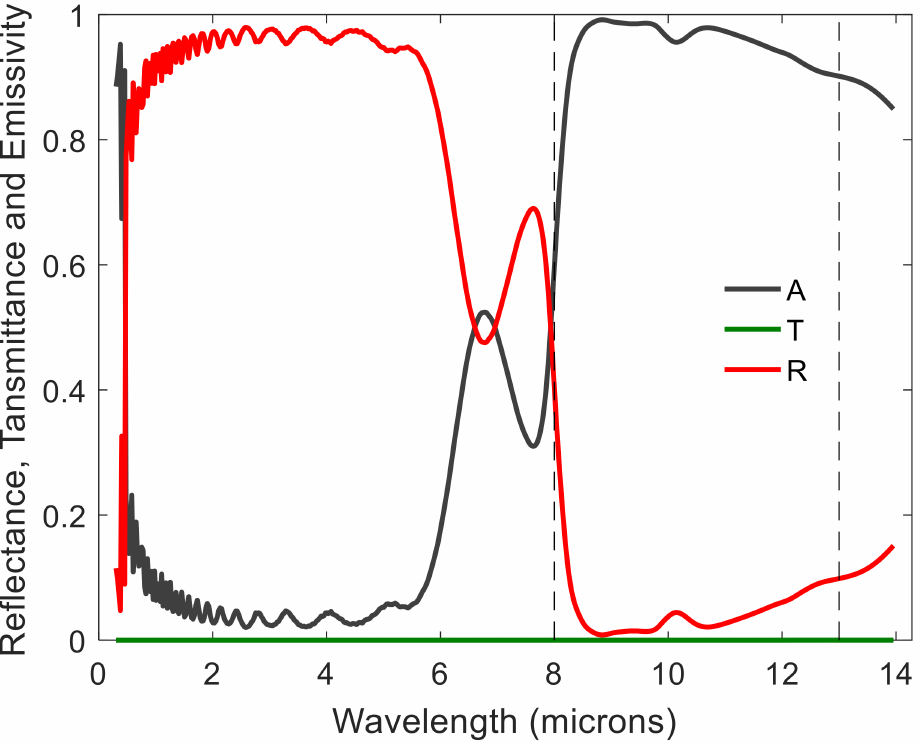
Figure 7. Calculated reflectance, transmittance, and emittance (emissivity) of the proposed